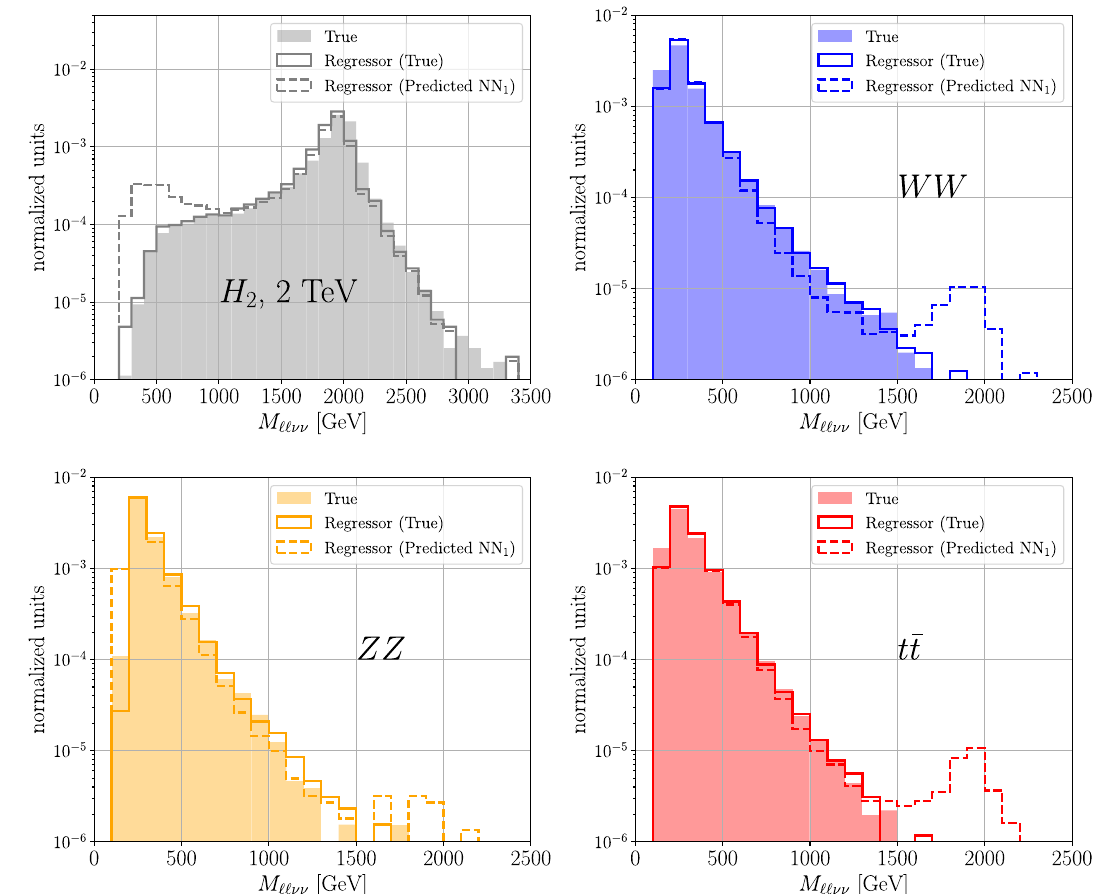
Fig. 6 The true (shaded areas), regressed from true samples (solid lines), and regressed from samples identified with NN1 (dashed lines) M (cid:2)(cid:2)νν distributions for the 2 TeV Higgs (upper left), WW (upper right), Z Z (γ ∗ ) (lower left) and t ¯ t background (lower right)